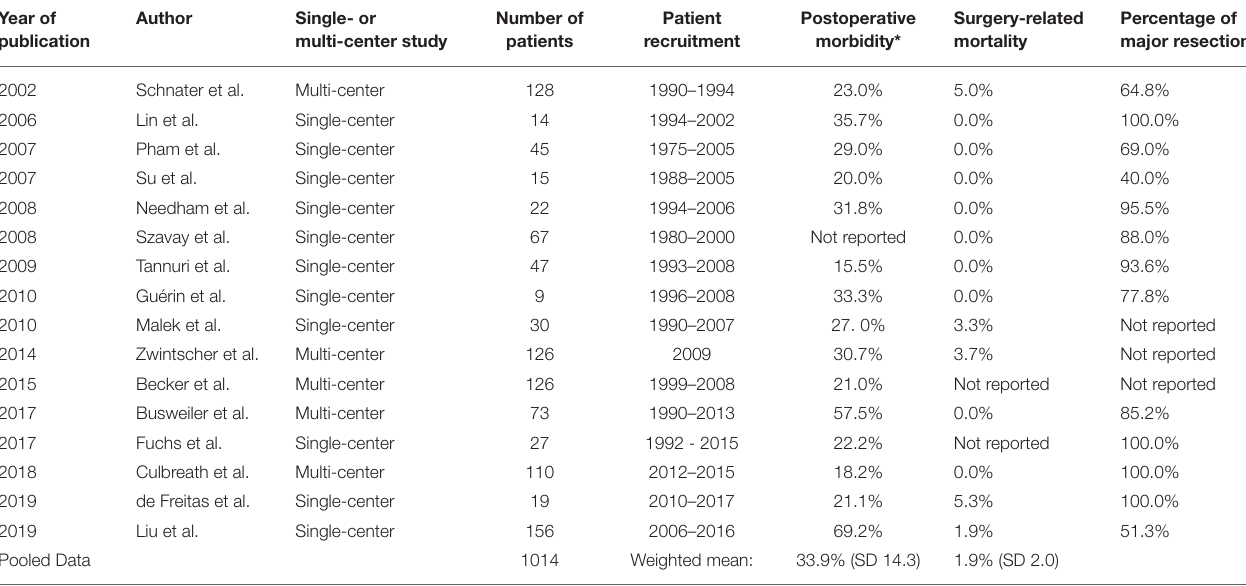
TABLE 6 | Studies of pediatric patients undergoing liver resection with reported postoperative